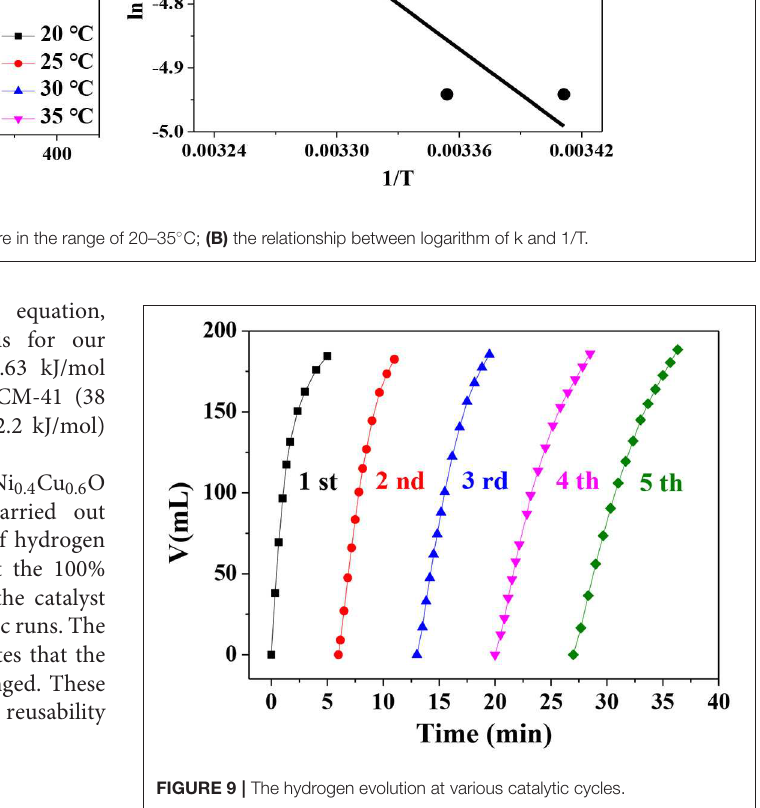
FIGURE 9 | The hydrogen evolution at various catalytic